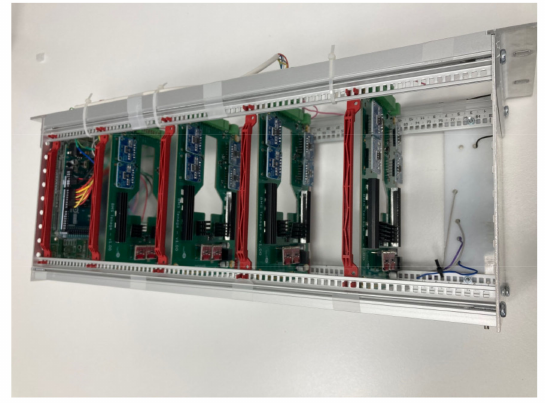
Figure 7. Integrated circuit assembly in a rack with the Arduino card. General